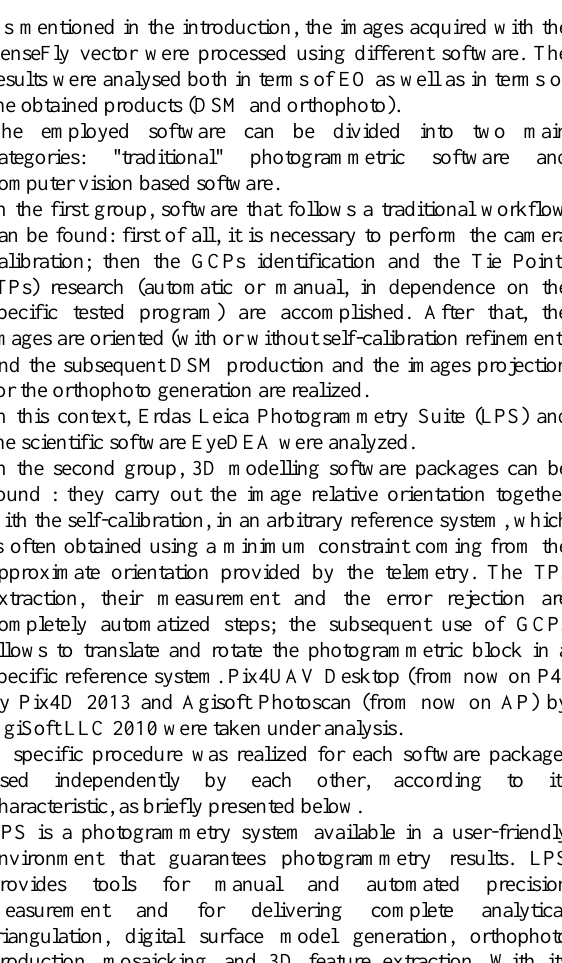
Figure 1 – Overview of the flown area